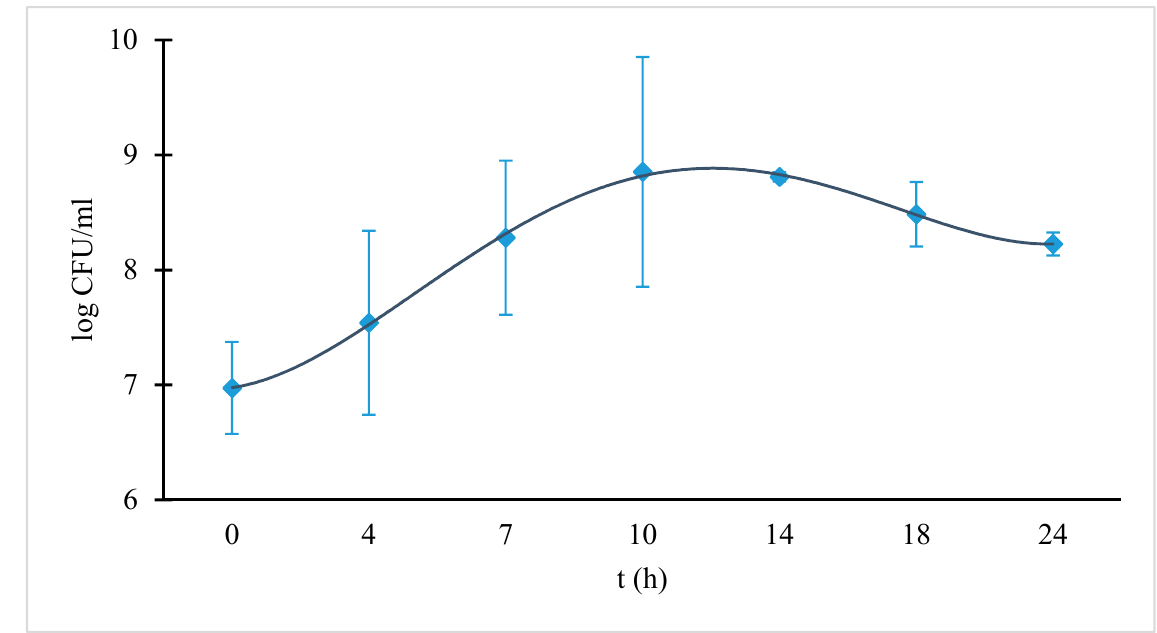
Figure 4. Growth curve of S. mutans measured in colony-forming unit per milliliter (CFU/mL) in a BHI (brain–heart infusion) nutrient broth. The diamonds correspond to measured values.